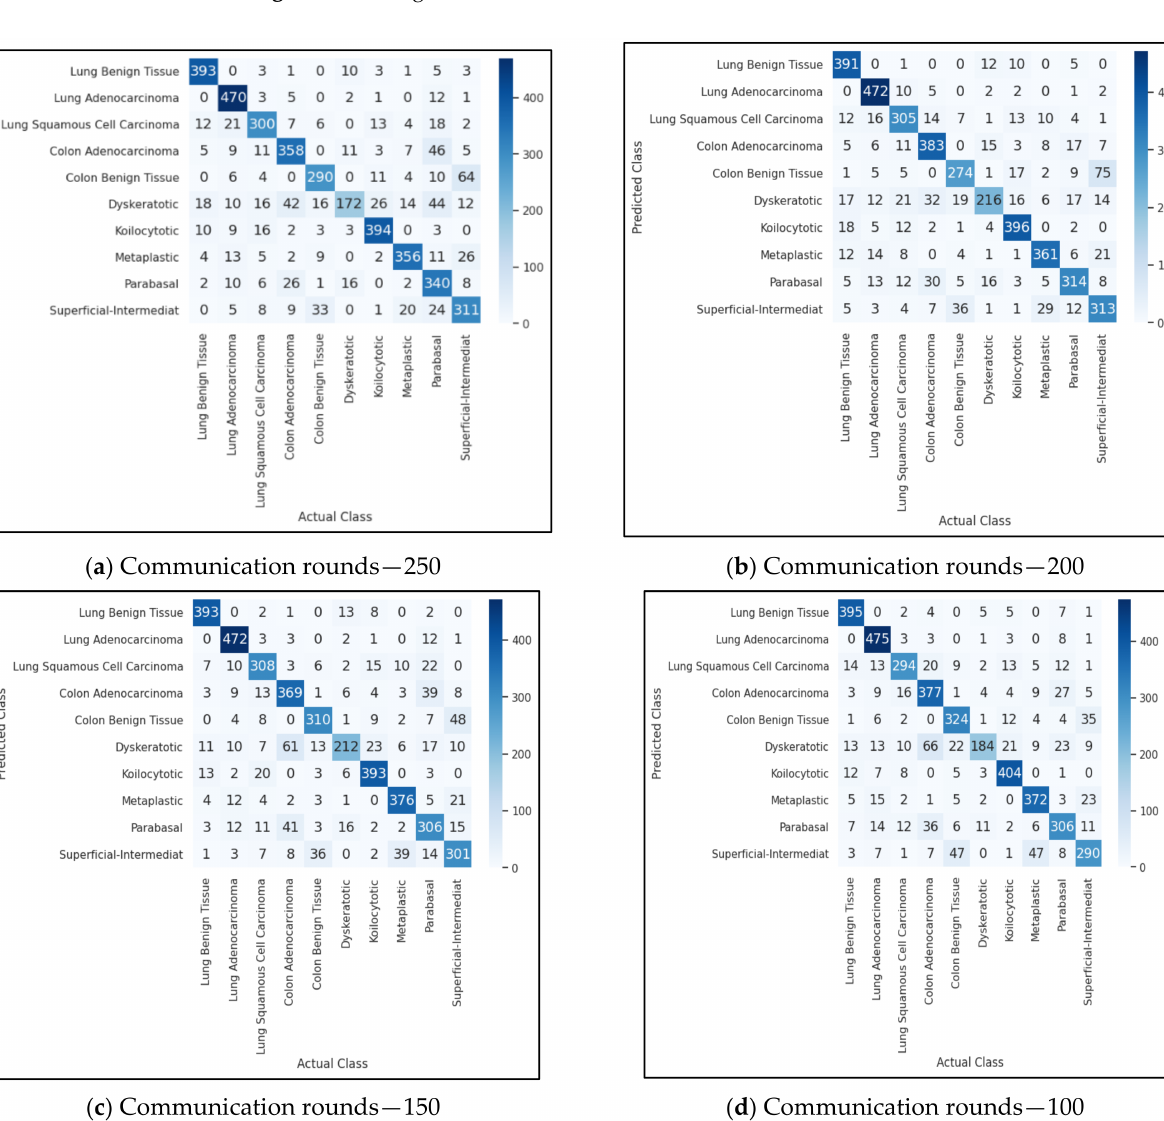
Figure 4. FedAvg—loss.